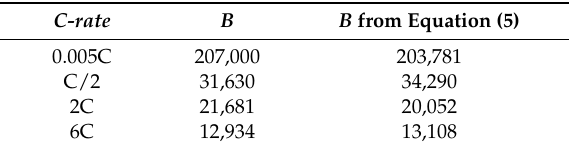
Table 3. B values used to calculate the C-rate vs. B power law approximation and obtained by Equation (5).